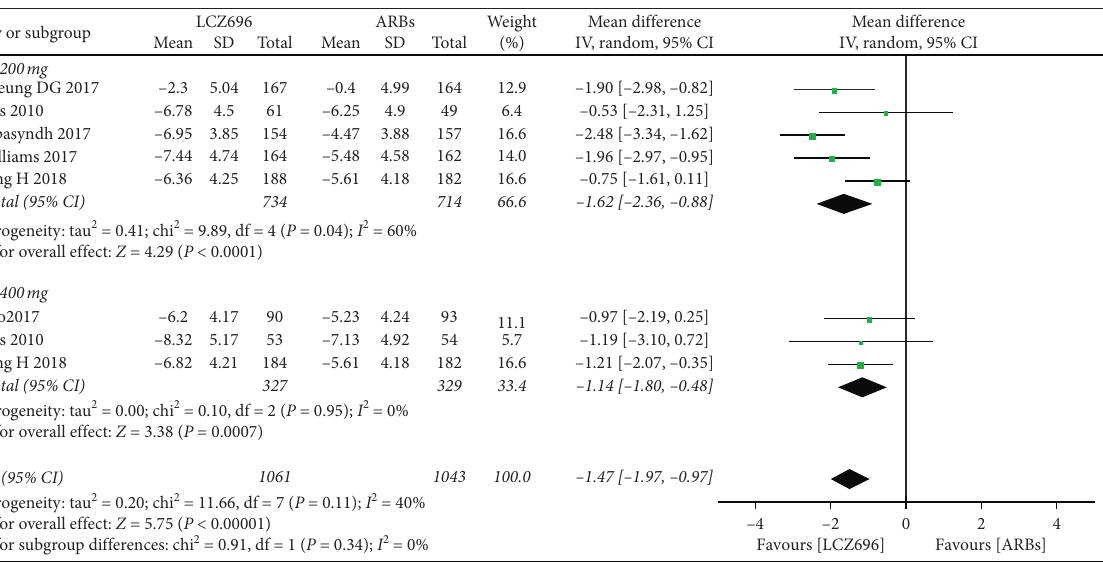
Figure 6: Comparison of LCZ696 with ARBs on mean reduction (mm Hg) in ambulatory diastolic blood pressure